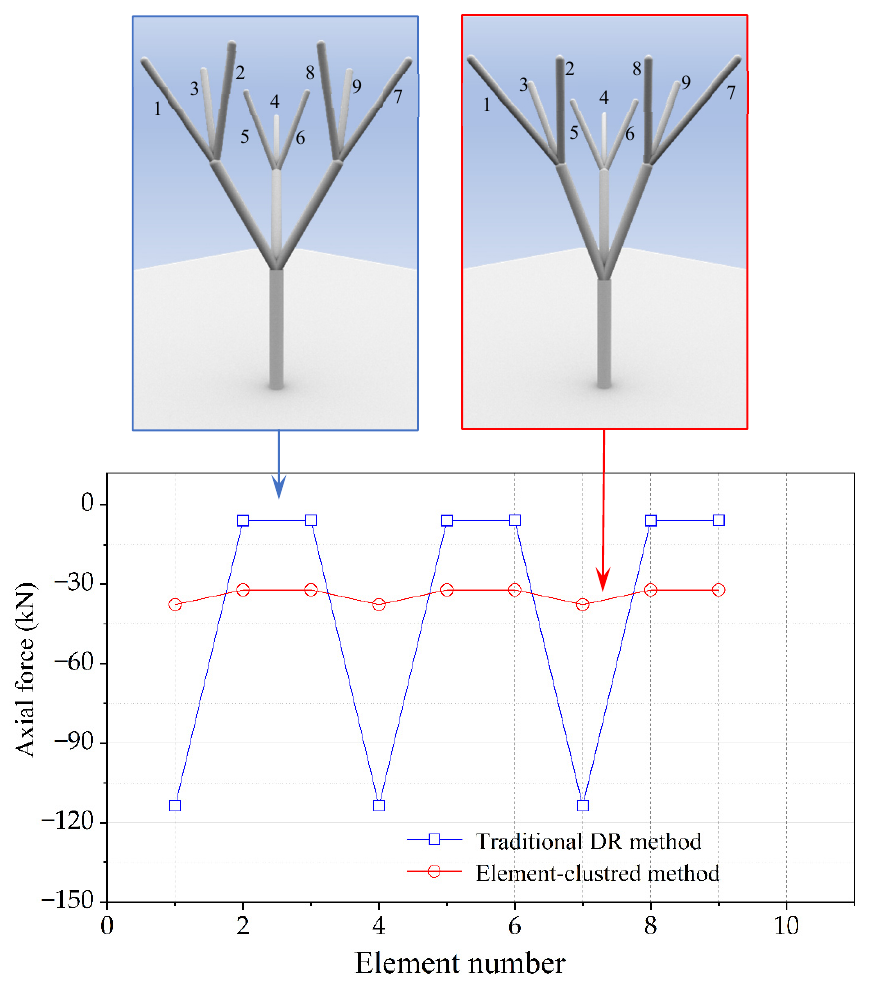
Figure 6. Comparison of axial forces in the members of branching structures.